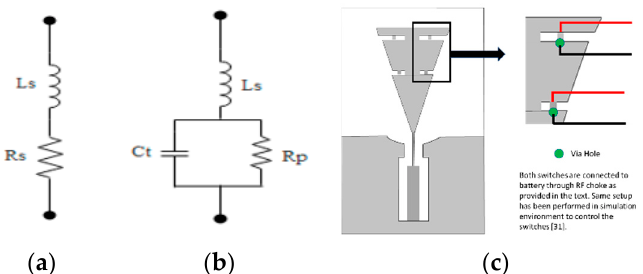
Figure 5. Positive-Intrinsic-Negative (PIN) diode equivalent circuit: ( a ) ON state. ( b ) OFF state, ( c ) Canonical biasing model of Case 3.